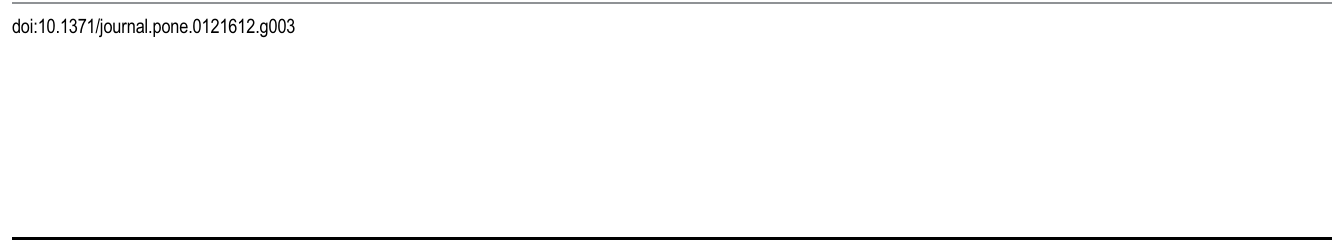
Fig 3. (A). Effect of different cytidine concentrations on CDA assay in H 2 O. Cytidine standard curves were conducted under standard reaction conditions in section 2.5 in H 2 O (B), LB medium (C), M9 medium (D) and 10-fold diluted LB medium (E), respectively. Each plot represents the average of three samples. Absorbance was measured using a microplate